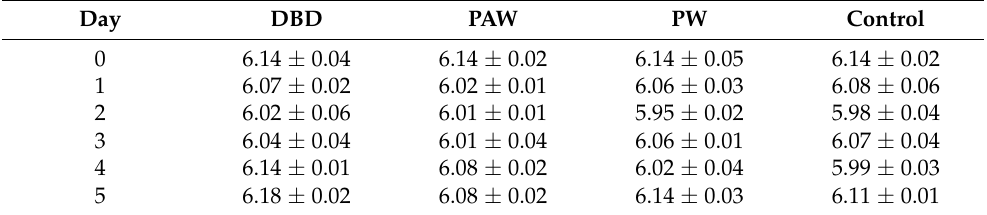
Table 2. The pH values of the PAW-, DBD-, PW-treated, and control button mushroom samples during